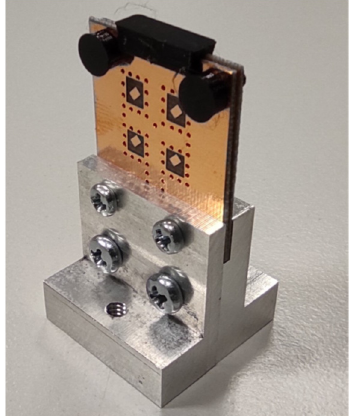
Figure 10. Manufactured array with the larger vias.